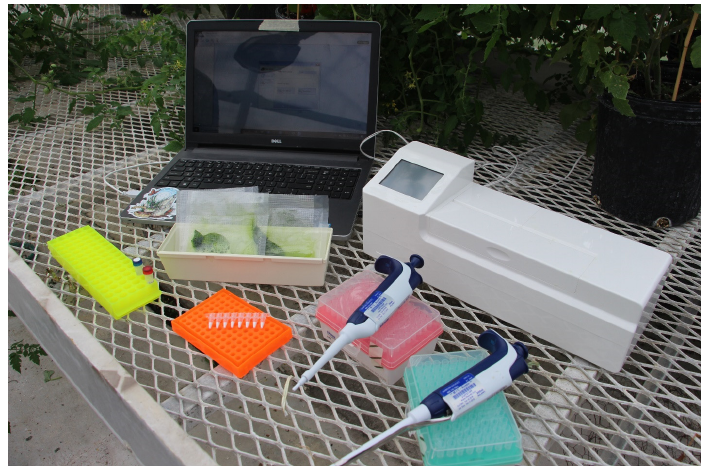
Figure 2. Visualization of the minimal space and equipment needed to perform the preformulated recombinase polymerase amplification (RPA) assay outside of the laboratory. AxxinT16-ISO used for visualization.